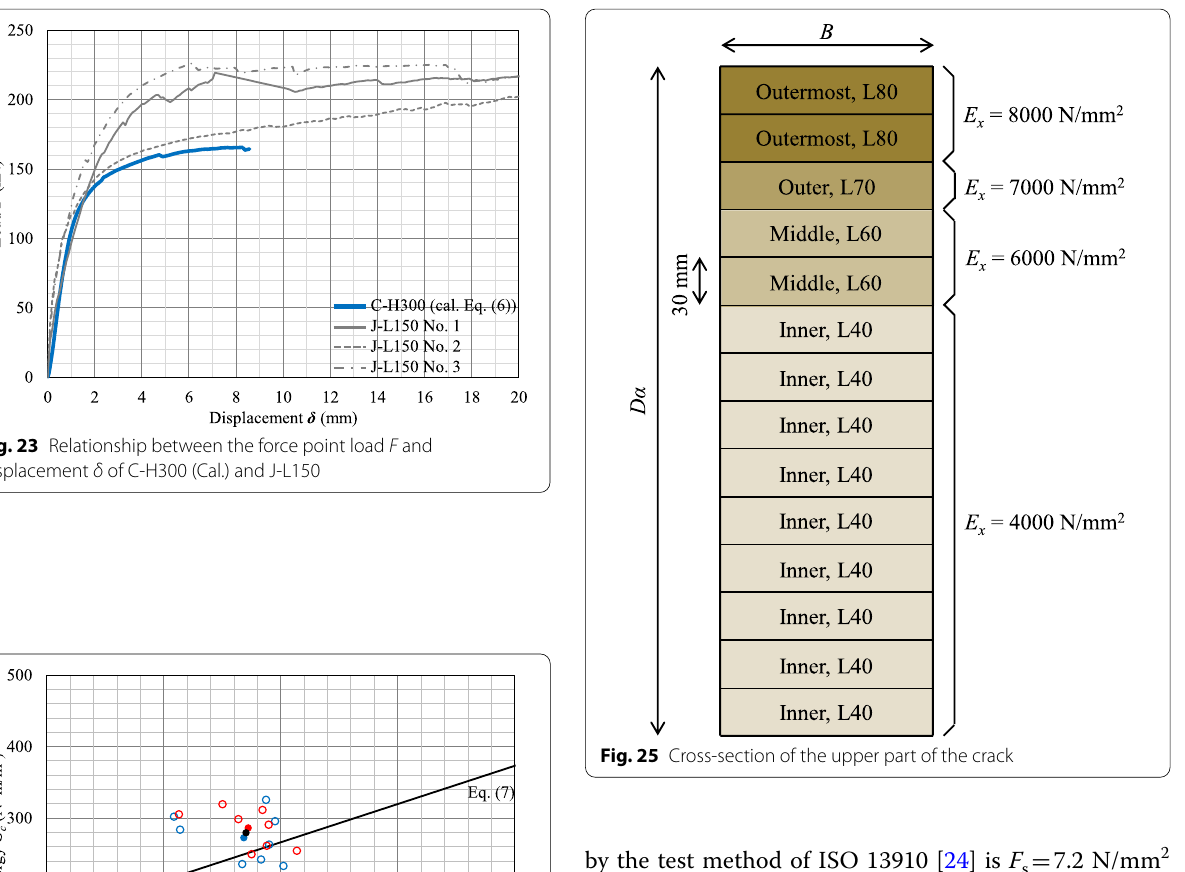
Fig. 24 Mode I fracture energy G c